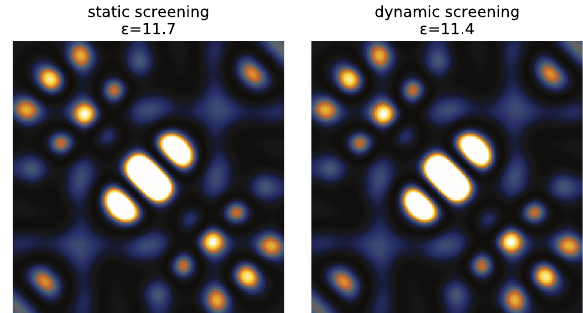
Fig. 7 Effect of dielectric screening on STM images. Comparison of simulated STM images of a single dopant computed using a dopant model with statically screened ( ϵ r = 11.7) Coulomb potential in the left-hand side fi gure and using a dynamic screening model in the right-hand side fi gure. The details of the dopant model do not seem to affect the resulting STM images as long as the eigenstate energies are the same for the different